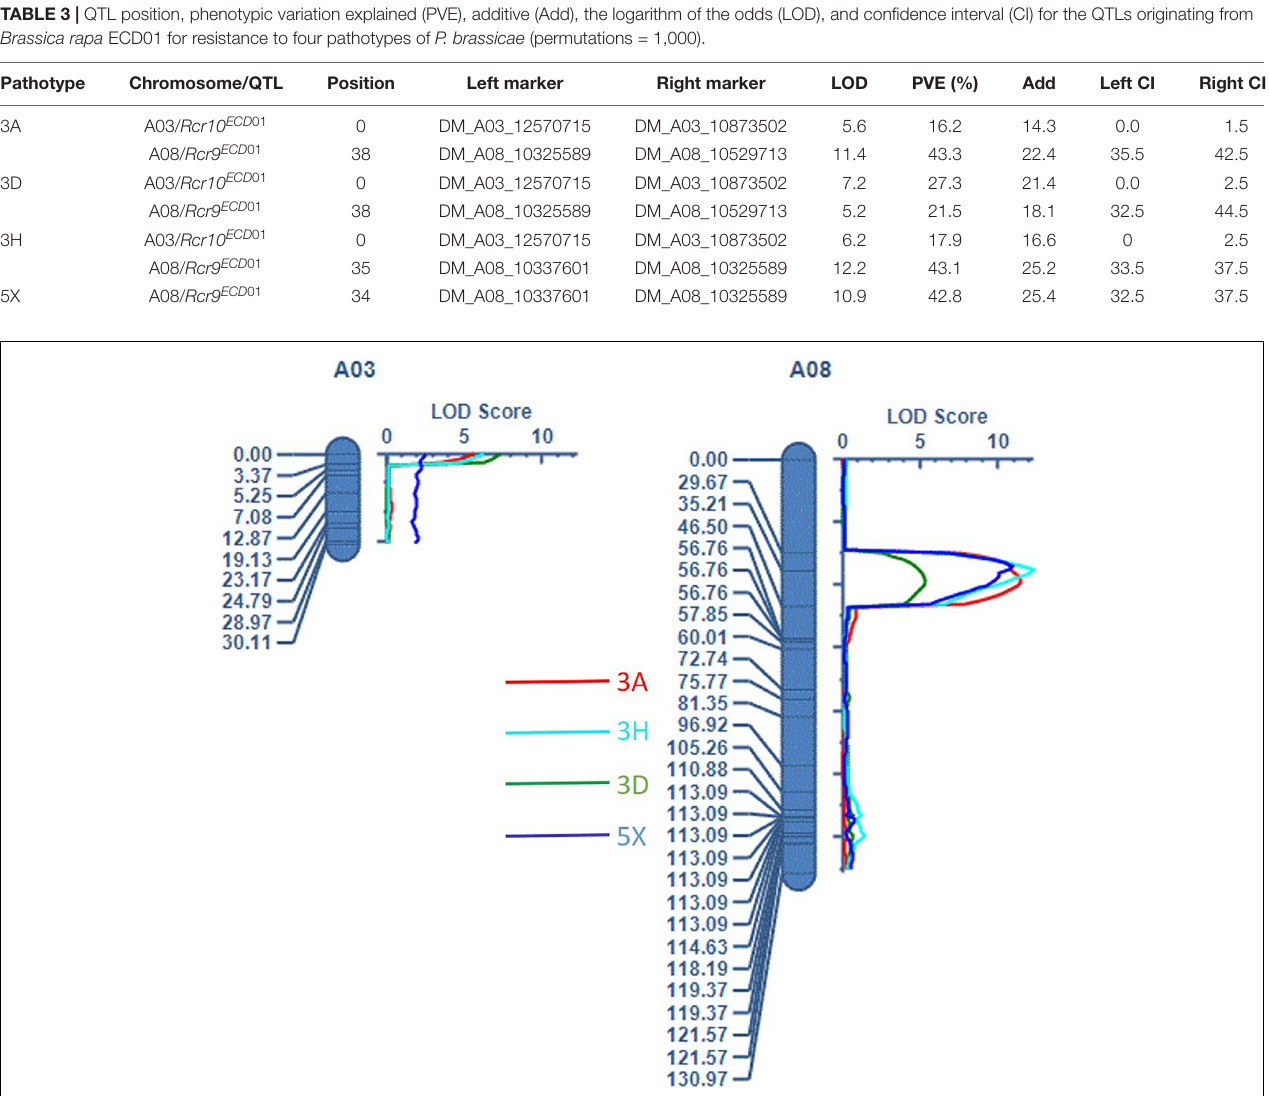
FIGURE 3 | Two QTLs were detected: Rcr10 ECD 01 on chromosome A03 and Rcr9 ECD 01 on